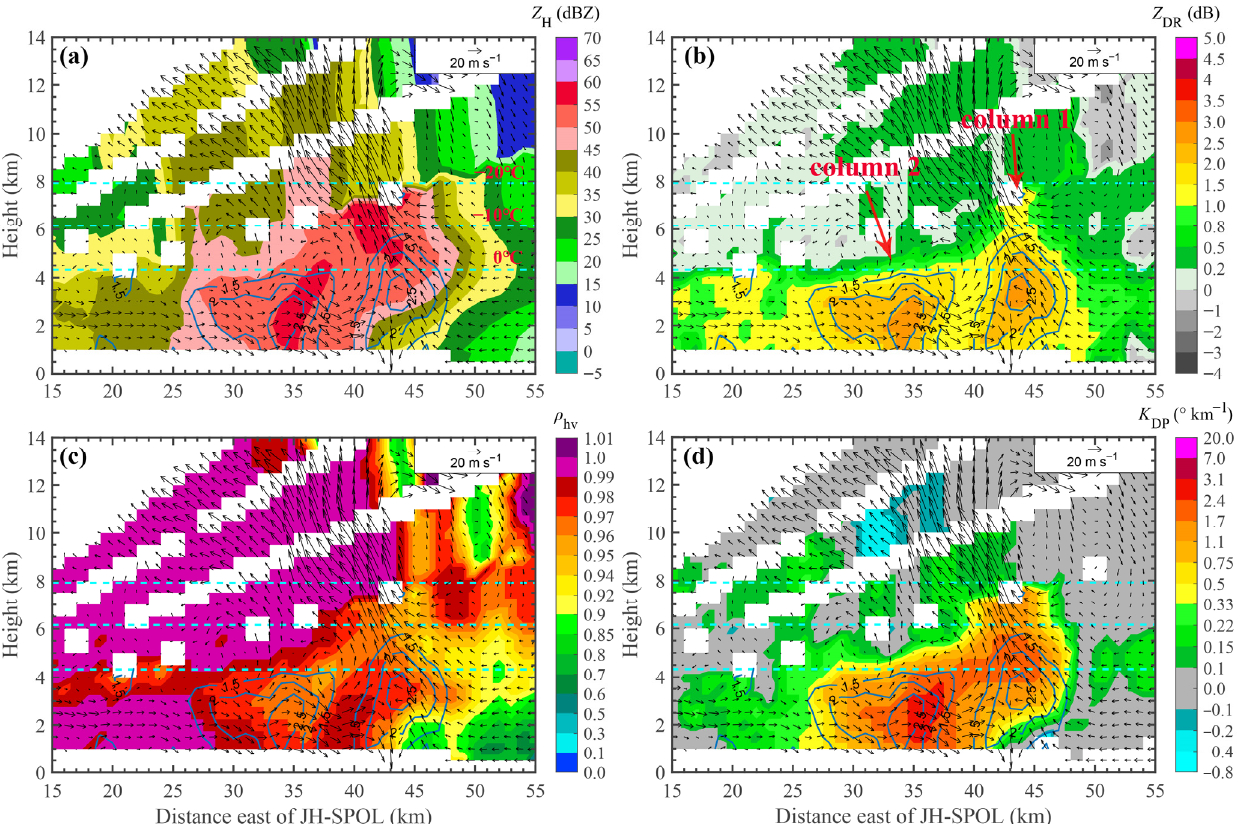
Figure 8. Vertical profile structures of dual-polarization signatures at 2300 BT on 10 May 2021, as produced along the dotted black line in Figure 7b. ( a ) Z H , ( b ) Z DR , ( c ) ρ hv , and ( d ) K DP . The black vectors represent the storm-relative wind field on the profiles retrieved from a combination of QZ- SPOL, JH-SPOL, and LSRD data. The solid blue lines represent the 1.5-, 2-, and 2.5-dB Z DR contours. The dotted blue lines represent the 0, − 10, and − 20 °C isotherms. Red arrows 1 and 2 represent the vertical structures corresponding to high- Z DR bands ① and ② along the dotted black line in Figure 7b, respectively.